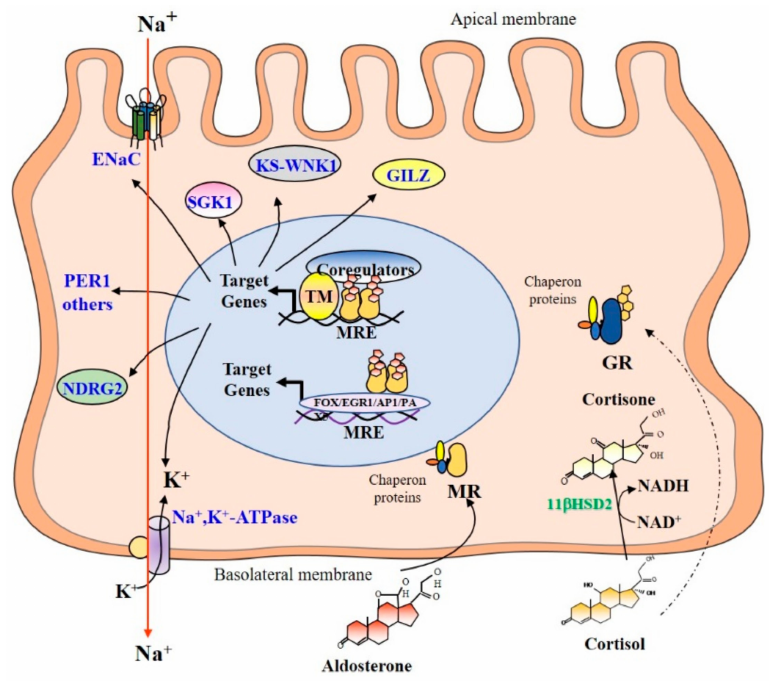
Figure 1. Mineralocorticoid and glucocorticoid signaling in renal principal cells. Corticosteroid hormones enter by passive diffusion and bind their respective receptor: aldosterone to MR and cortisol/corticosterone to GR. In the absence of ligands, corticosteroid receptors are associated to chaperone proteins. Thereafter, the binding of either ligand induces the dissociation of these chaperone proteins and conformational changes of MR and GR. In the nucleus, the aldosterone/MR complex binds mostly as homodimers to Mineralocorticoid Response Elements (MREs). Then, MR interacts, in a cyclic, sequential, and/or combinatorial manner, with transcriptional coregulators and some basal transcription factors or components of the machinery to enhance the transcription of target genes, including the Epithelial Na + Channel (ENaC), the Na + , K + -ATPase pump. Aldosterone also stimulates early expression of the Serum and glucocorticoid-regulated kinase 1 ( SGK1 ), the serine/threonine kinase With No lysine K kinase ( KS-WNK1 ), the N-myc Down-Regulated Gene 2 ( NDRG2 ), and the Glucocorticoid-Induced Leucine Zipper protein ( GILZ ). Recently, aldosterone was shown to stimulate early expression the PER1 gene, which belongs to the circadian clock gene family. It was also reported that MR can indirectly bind to recognition motifs for other transcription factors (FOX, EGR1, AP1, PAX5) through tethering mechanisms. In principal renal cells, the 11 β HSD2 converts glucocorticoid hormones into cortisone or 11-dehydrocorticosterone that have little or no affinity for MR, or even for GR. Thus, the 11 β HSD2 allows aldosterone to act selectively onto MR to specifically exert its biological effects on sodium reabsorption. In addition, GR is not or weakly activated. MR: Mineralocorticoid Receptor; GR: Glucocorticoid Receptor; MRE: Mineralocorticoid Response Element; GILZ: Glucocorticoid-induced leucine zipper; ENaC: Epithelial Na + Channel; Sgk 1: Serum and Glucocorticoid-Regulated kinase 1; KS-WNK1: With No lysine K kinase; NDRG2: N-myc Down-Regulated Gene 2; PER 1: clock gene period 1; TM: Transcriptional